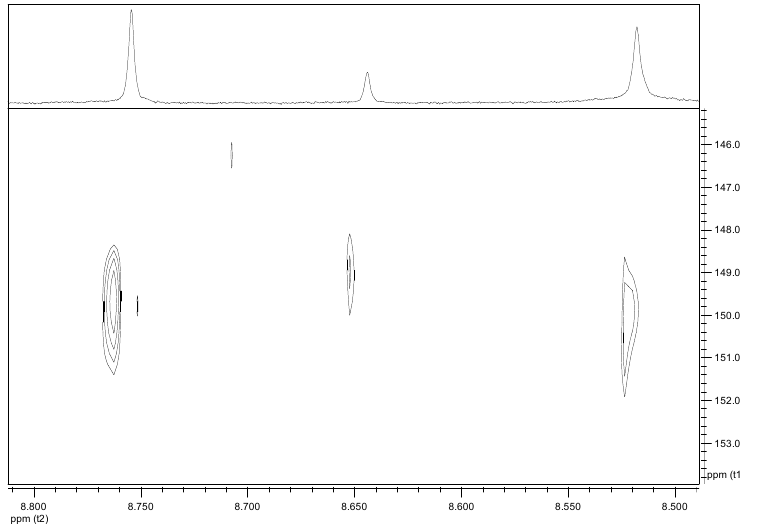
8.5008.5508.6008.6508.7008.7508.800 ppm (t2) Figure 5. HSQC spectrum showing the resonances of triazolic H-5 for the RBV and its metabolites.